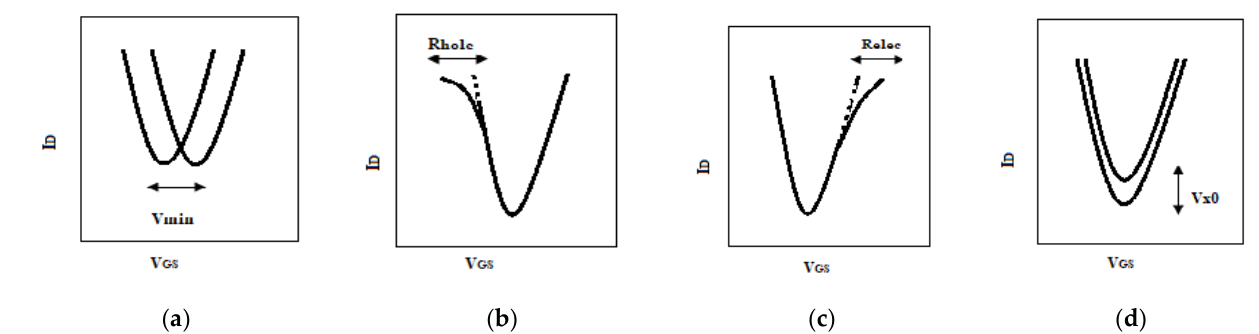
Figure 10. DNA molecule effects on Ids/Vgs profile of GFET. ( a ) Charge-neutral point movement; ( b ) the hole branch slope changing due to the DNA molecule; ( c ) the electron branch slope changing due to the DNA molecule; ( d ) the height changing of the charge-neutral point due to DNA molecules.